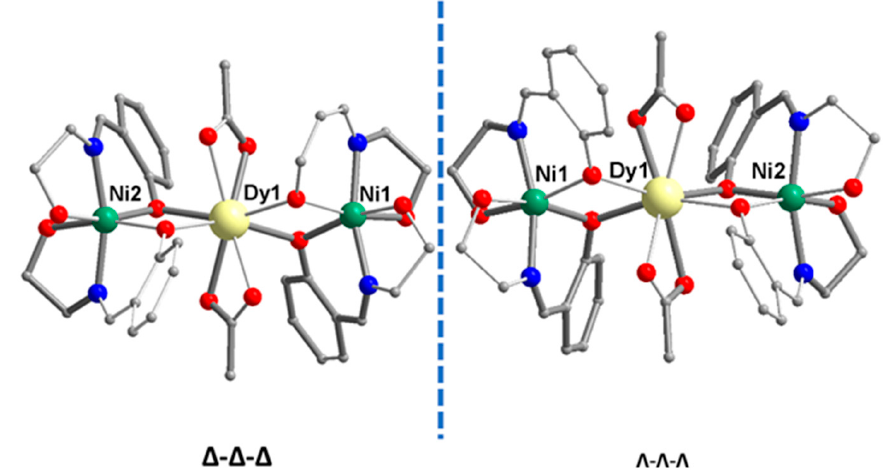
Figure 2. Enantiomeric mirror images in the structure of the complexes 1 , 2 and 3